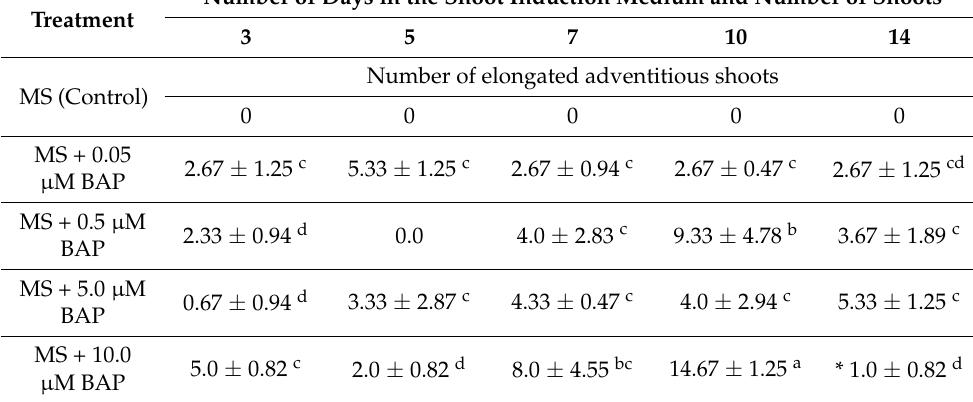
Table 1. Adventitious shoot bud induction in the nodal explants of S. havanensis in response to the various concentrations of cytokinin